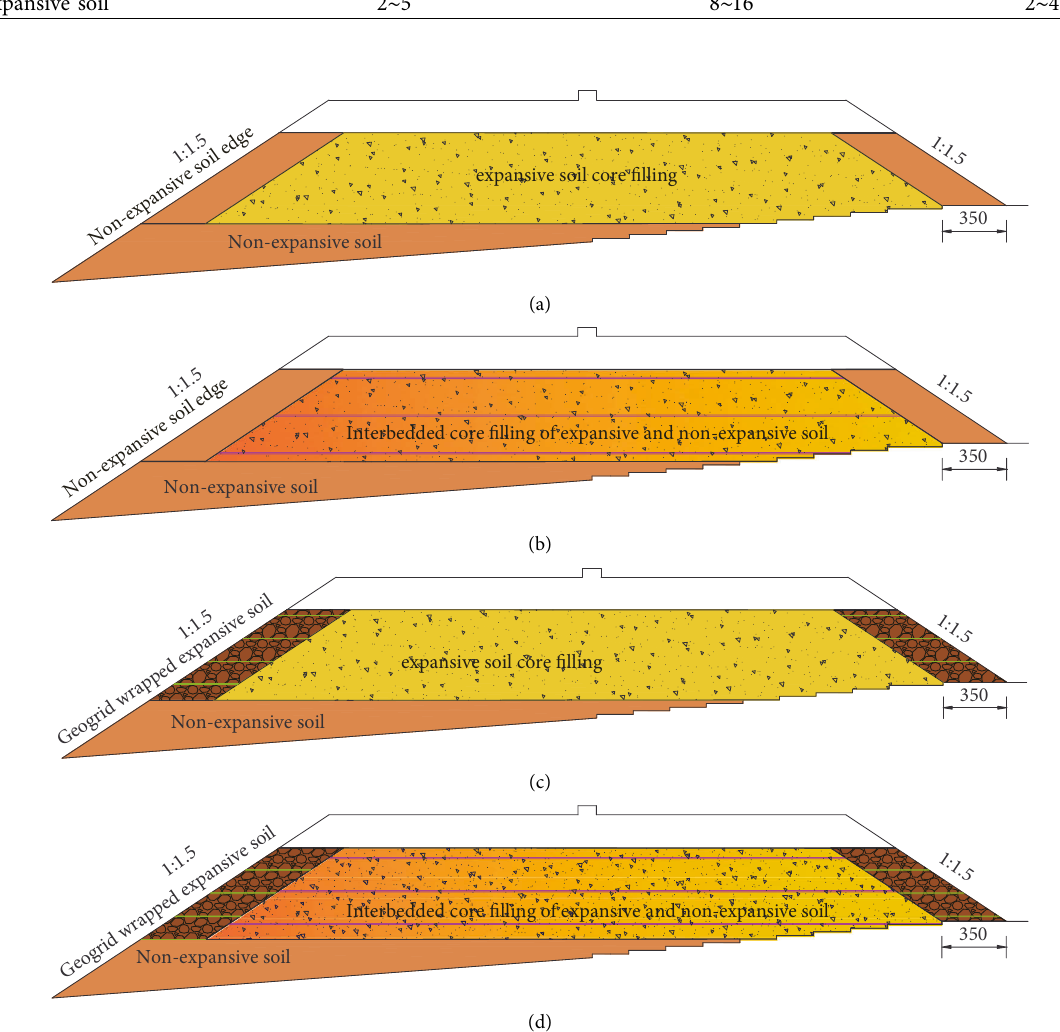
Figure 3: Treatment scheme under the cladding method.